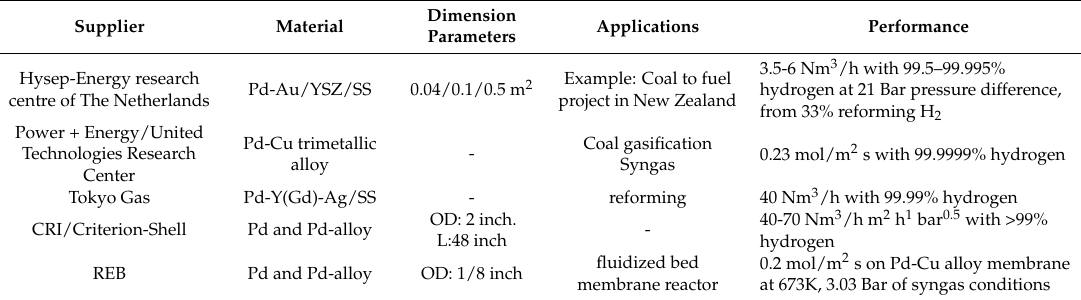
Table 4. Available commercial metal membranes for hydrogen separation